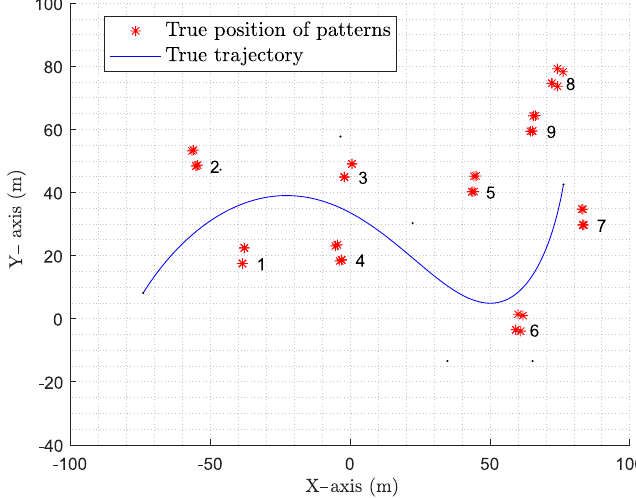
Figure 5. Simulated true trajectory and ellipse center positions of 9 coded labelled